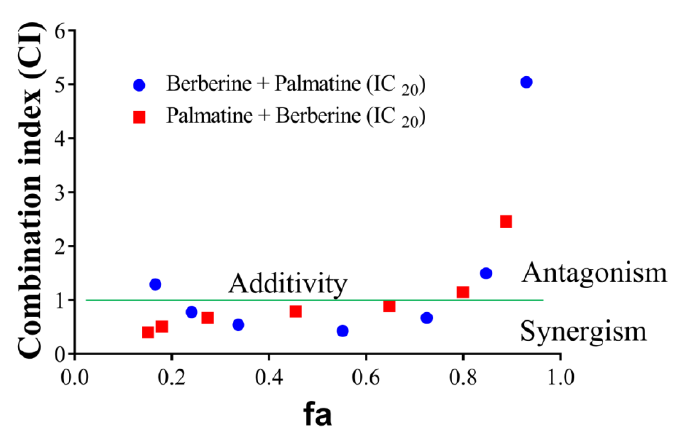
Figure 5. CI-fa plot of palmatine and berberine. ( (cid:8) ) varying berberine concentration from 0.05 to 50 µ g / mL and fixed palmatine concentration (IC 20 ), ( (cid:8) ) varying palmatine concentration from 0.05 to 50 µ g / mL and fixed berberine concentration (IC 20 ).